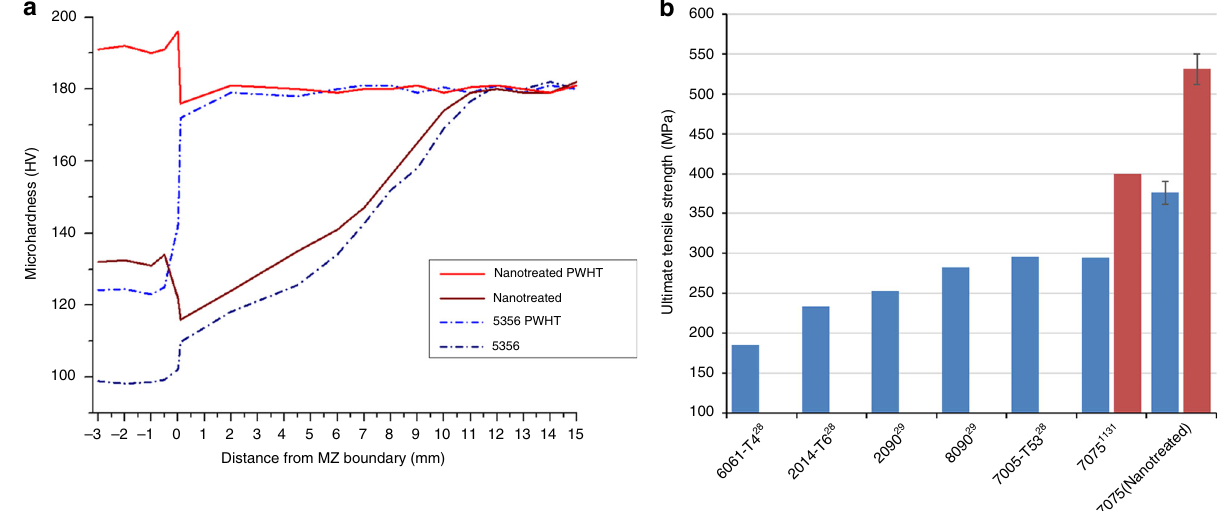
Fig. 5 Mechanical properties of nano-treated AA7075 welds. a Microhardness tests were conducted at the centerline of transversal vertical cross-sections. The graph compares the Vicker ’ s hardness values of welds performed with ER5356 fi ller and nano-treated AA7075 fi ller in as-welded and post weld heat treatment condition. b from left to right, the blue bars show a selection of commonly GTAW welded high strength aluminum alloys 36, 37 , AA7075 welded with ER5356 fi ller material 11 and AA7075 welded with nano-treated AA7075 fi ller material. The red bars show an AA7075 modi fi ed indirect electric arc weld (MIEA) with ER5356 as fi ller 38 and AA7075 welded with nano-treated AA7075 fi ller material after the same PWHT. Error bars show s.d. of 4 tested